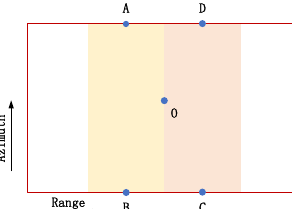
Figure 3. Schematic diagram of RFI; Point A, B, C, D and O are the five targets in the scene. A and B are in the same range cell, and the same is true for point C and D. Point O is the center of ABCD. The red frame represents the beam coverage of the LEO SAR and the yellow interference zone is from the RFI signal at point A and the pink interference zone is from the RFI signal at point D. Therefore, the size of zone ABCD is the key to calculate the RFI power affecting cell O. Obviously, the size of zone ABCD can be estimated by the product of AB and BC. AB is the azimuth direction length of beam coverage of LEO SAR on the ground. BC is the length of the interference zone in the range direction; we call it 1 G L L − , which can be written as